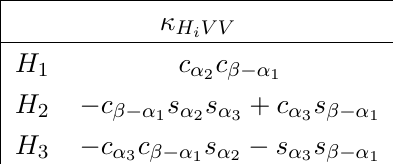
Table 1 . Neutral CP-even Higgs H i couplings to the massive gauge bosons V = W; Z